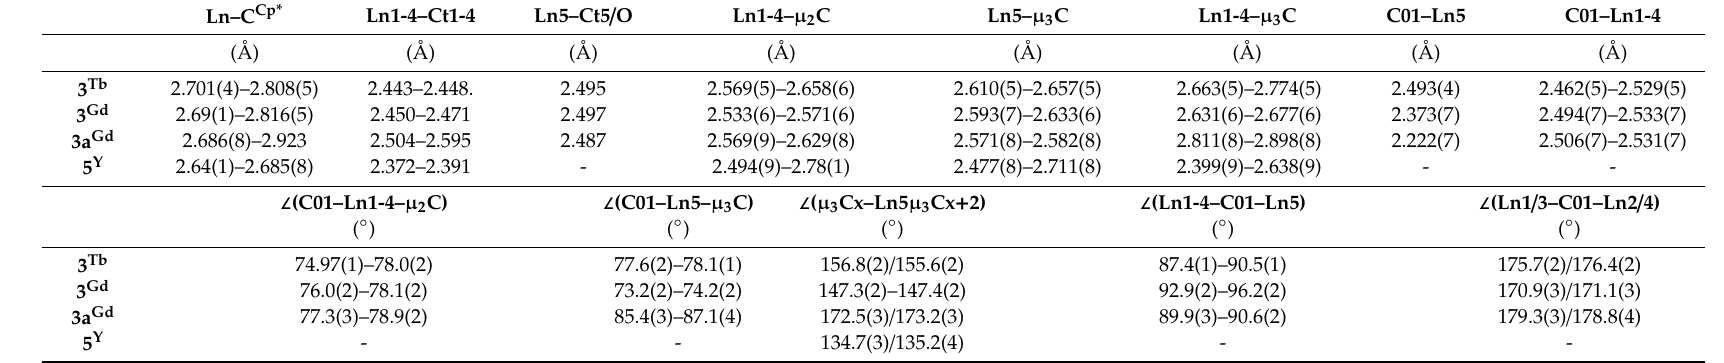
Table 7. Comparison of the pyramidal pentanuclear crystal structures of 3 Ln , 3a Gd and 5 Y